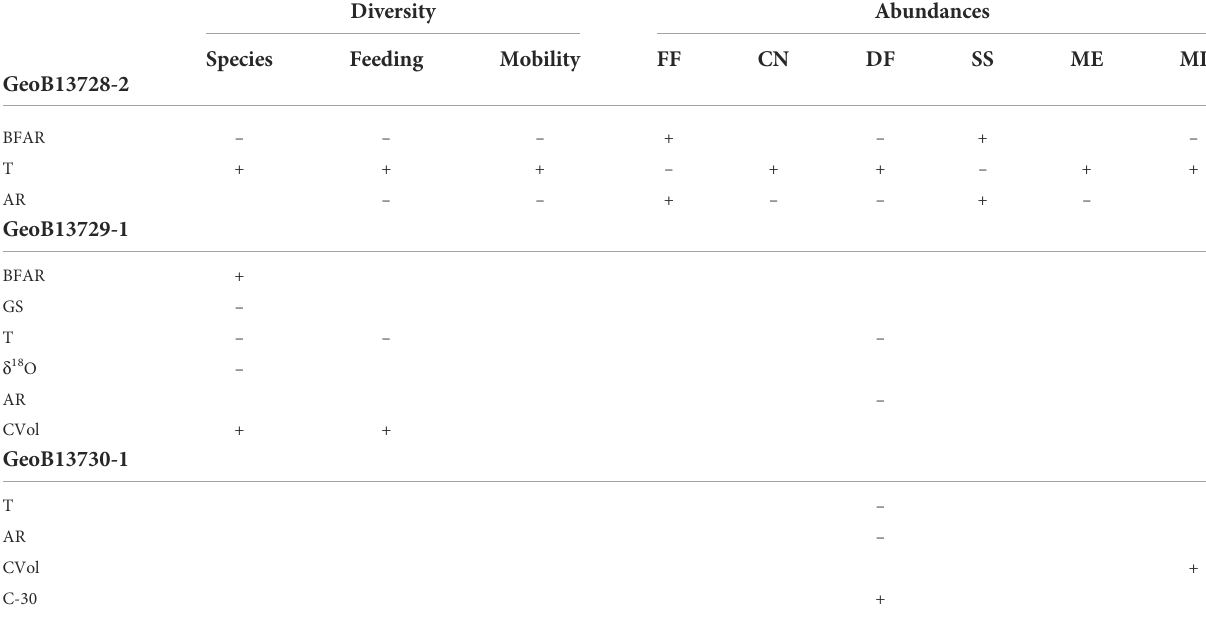
TABLE 2 Signi fi cant Spearman correlations between palaeoceanographic and habitat characteristic parameters with molluscan diversity (species, feeding, and mobility groups) and proportional abundances of molluscan traits. Diversity Species Feeding